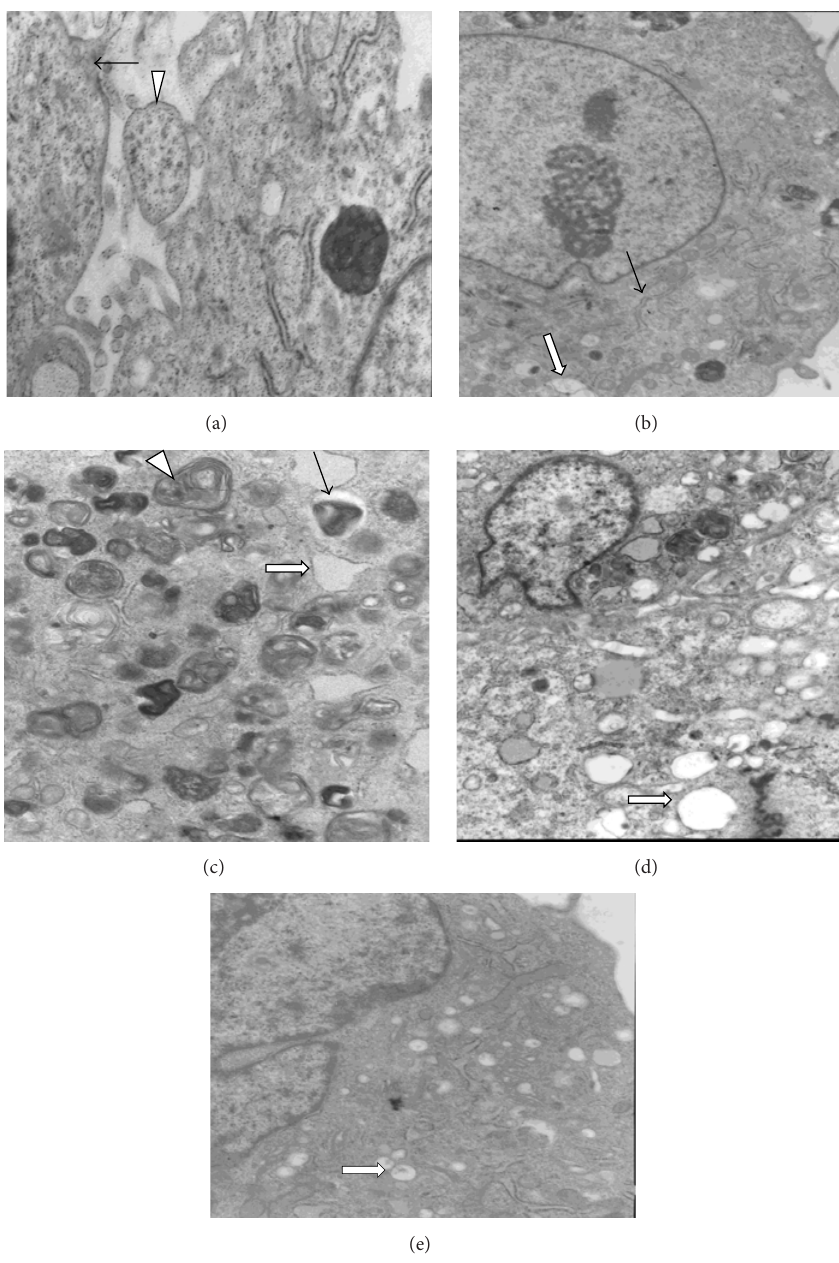
Figure 3: Soybean oils but not fish oils cause ER and mitochondrial damage. Primary hepatocytes were treated with 0.4% or 1% soybean (SO) or fish oil- (FO-) based lipid emulsions and the changes to both ER and mitochondrial morphologies were examined using TEM ( × 10000). (a) CON group, (b) FO High group, (c) FO Low group, (d) SO High group, and (e) SO Low group. White filled triangle indicates mitochondria;